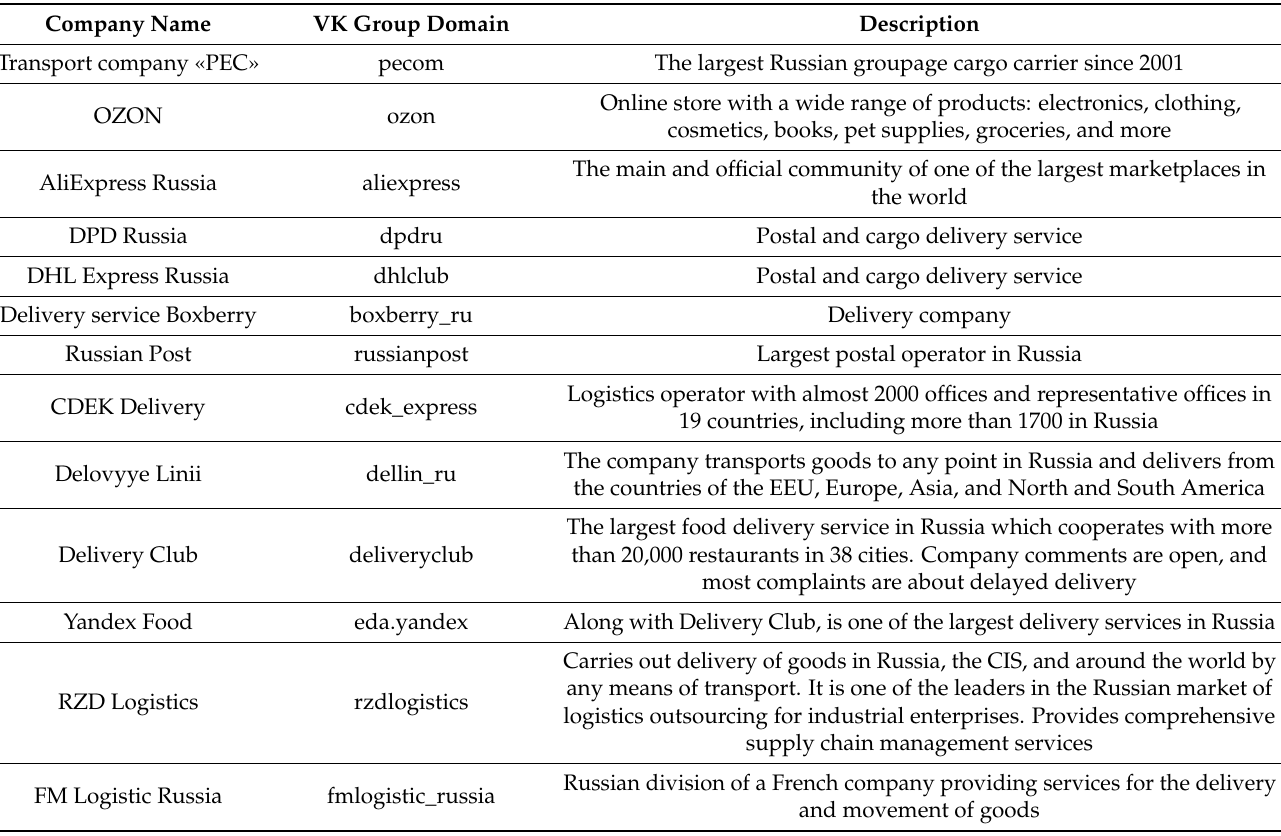
Table 4. Results of collecting informational component tokens.